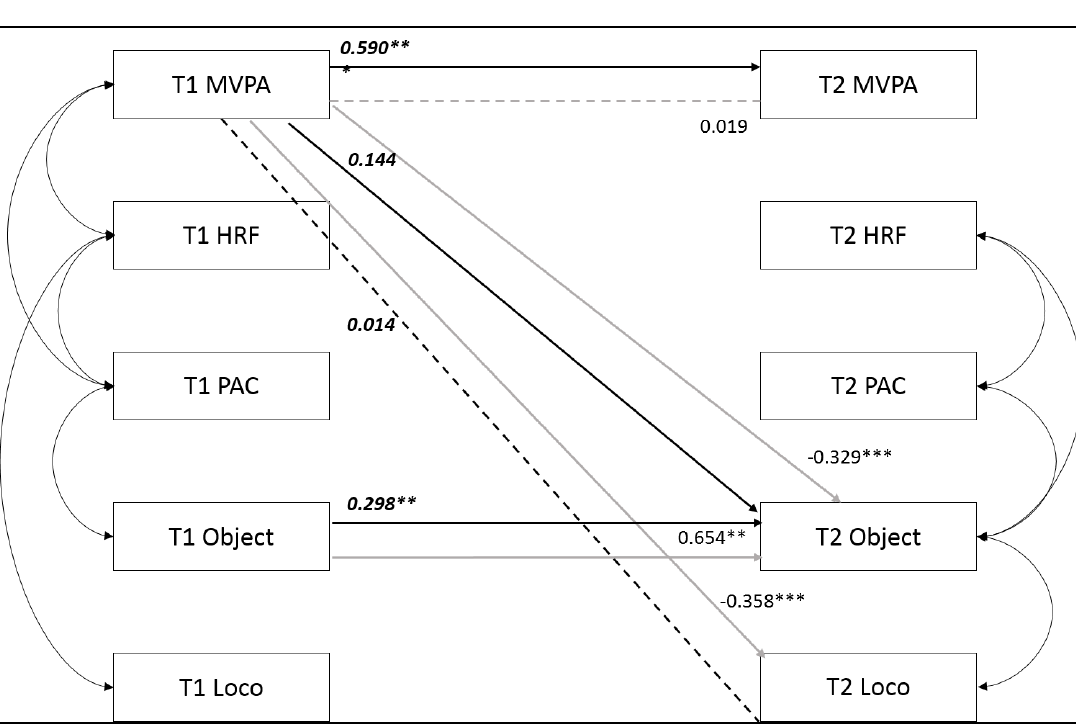
Figure 2. Pathways between variables from 6th class (T1) to 1st year (T2) that were statistically significantly different between males and females. Only significantly different pathways are shown. All other pathways were not statistically different by sex. Note: * Standardised regression coefficients significant at p < 0.05; ** p < 0.01; *** p < 0.001. Grey line = female pathway; black line = male pathway. Dashed line = non-significant pathway. Regression coefficients shown in italics = male values.